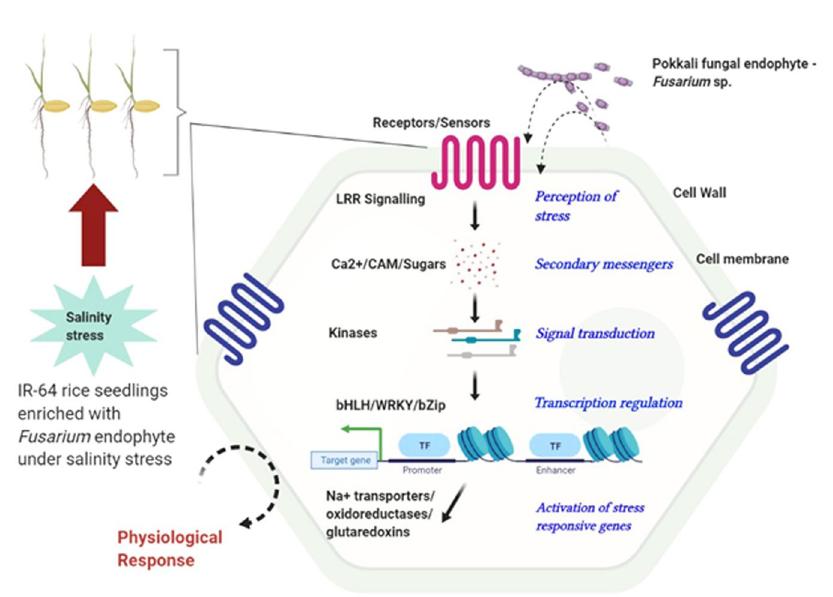
Figure 7. Schematic representation of possible signaling cascades induced by Pokkali endophyte, Fusarium sp . in IR-64 plants subjected to salinity